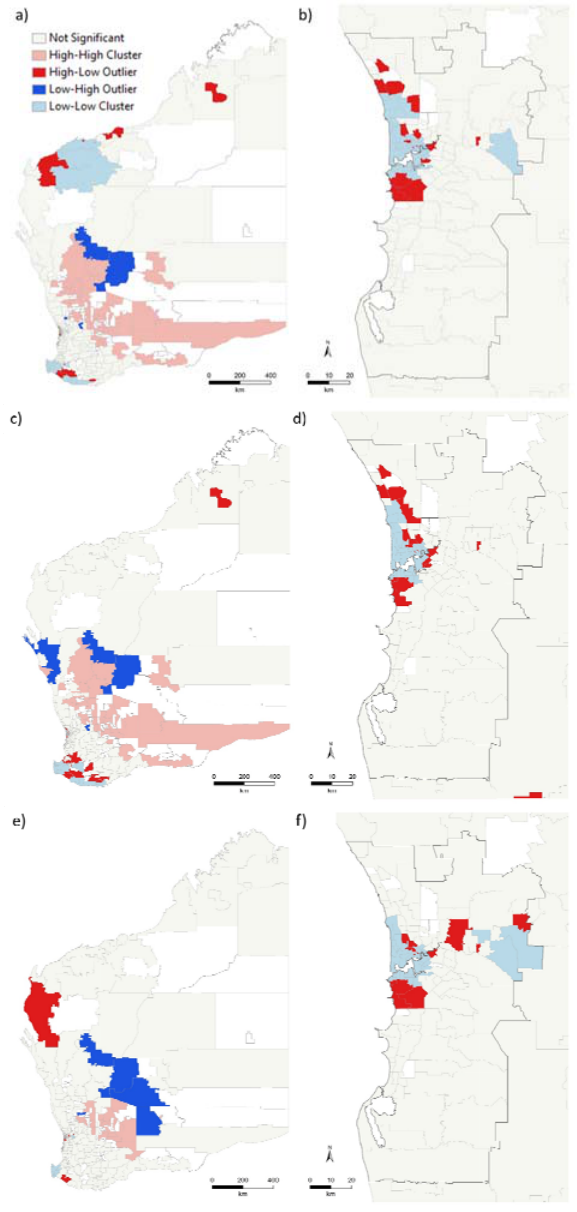
Figure 5. PHC local autocorrelation analysis relative to State (a,b), ARIA-based regions (c,d) and Health Regions